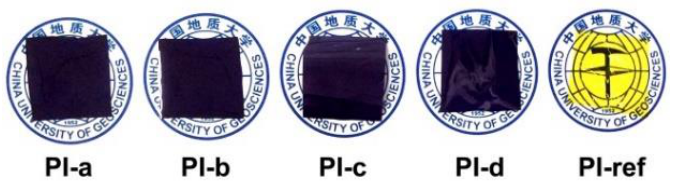
Figure 5. Appearance of black PI and PI-ref films.